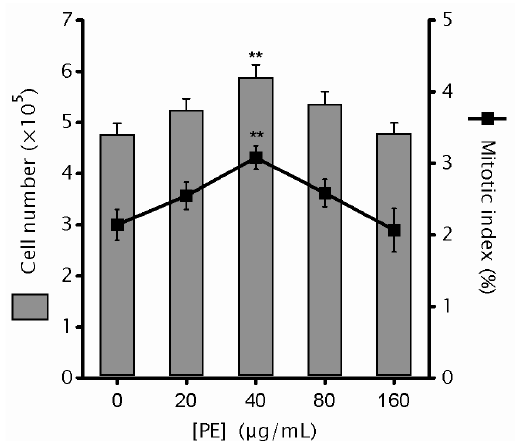
Figure 1. Influence of P. emblica (PE) treatment on cell growth rate of NCM460 cells. NCM460 cells with a seeding density of 1 × 10 5 /mL were incubated without or with PE (20–160 µg/mL) for 72 h, then cells were harvested and scored for total cell numbers (gray bars) and mitotic index (line with black squares). Total cell numbers were determined by counting live cells on a hemacytometer with the inclusion of trypan blue. Mitotic cells were scored based on their cell shape and DNA morphology after cells were fixed and stained with Giemsa. Five separate fields with >100 cells each were counted. Data are expressed as mean values ± SEM. ** p < 0.01 vs. untreated control.